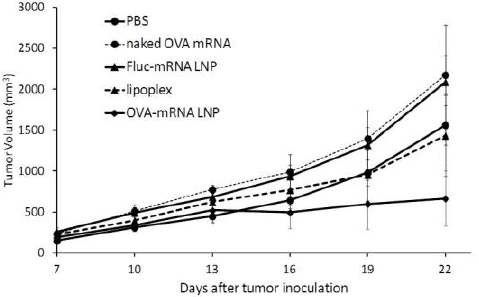
Figure 5. Therapeutic anti-tumor effect. C57BL/6J mice were inoculated with E.G7-OVA cells. The mice were treated with different solutions at 8, 11, and 14 days after tumor inoculation and tumor volume was monitored. Mice groups were treated with PBS, naked OVA-encoding mRNA (naked OVA-mRNA), LNP encapsulating luciferase-encoding mRNA (Luc-mRNA LNP), LNP encapsu- lating OVA-encoding mRNA (OVA-mRNA LNP), and RNA-LPX loading OVA-encoding mRNA (RNA-LPX). The plots represent the mean +/ − SEM (total of 5 mice/group, NS: not significant, Tukey-Kramer test).